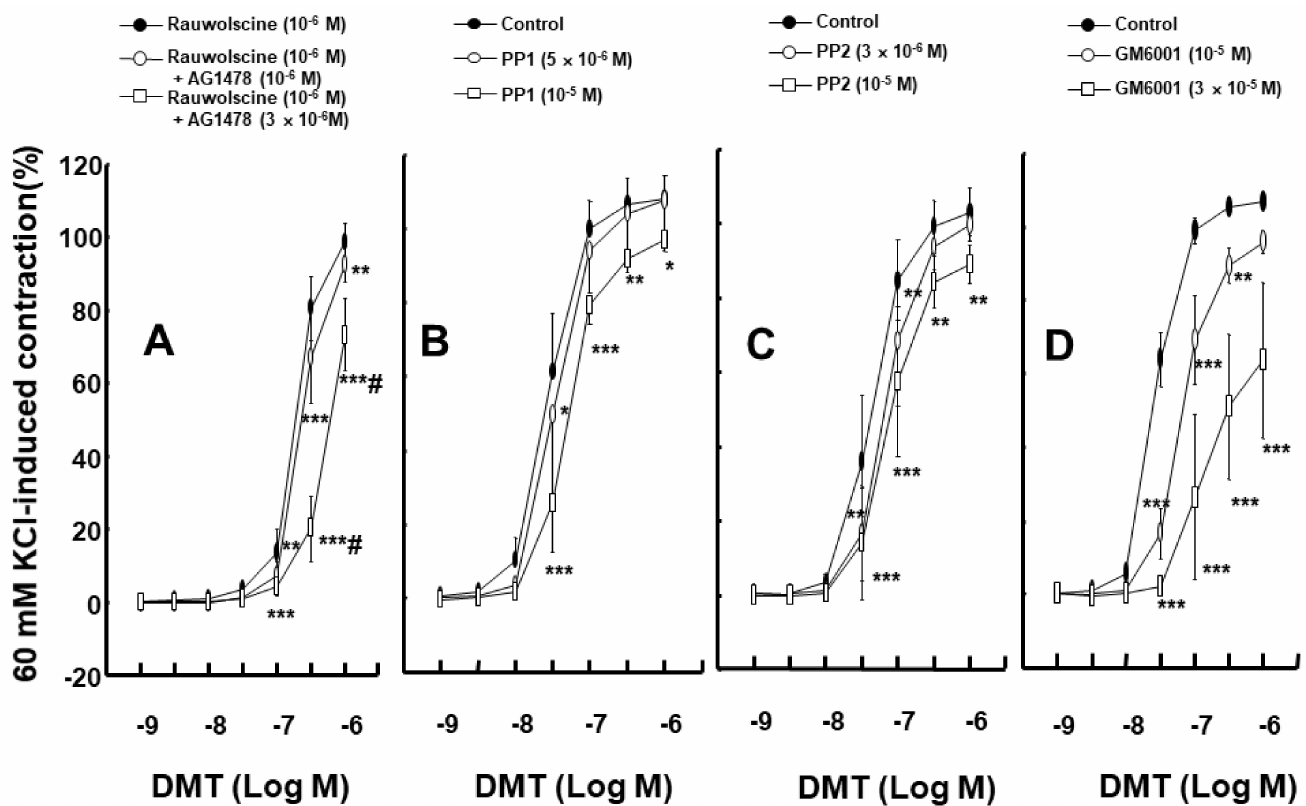
Figure 2. ( A ): Effect of AG1478 (N = 7, 6, and 5 for rauwolscine alone, rauwolscine plus 10 − 6 M AG1478, and rauwolscine plus 3 × 10 − 6 M AG1478, respectively) on dexmedetomidine (DMT)- induced contraction in isolated endothelium-denuded rat aortas pretreated with 10 − 6 M rauwolscine. Data are shown as mean ± SD and are expressed as a percentage of isotonic 60 mM KCl-induced contraction. N indicates the number of rats. ** p < 0.01 and *** p < 0.001 versus rauwolscine alone. # p <0.001 versus 10 − 6 M rauwolscine plus 10 − 6 M AG1478. ( B – D ): Effects of PP1 (( B ) N = 6, 5, and 6 for control, 5 × 10 − 6 , and 10 − 5 M PP1, respectively), PP2 (( C ) N = 6, 5, and 6 for control, 3 × 10 − 6 , and 10 − 5 M PP2, respectively), and GM6001 (( D ) N = 5, 5, and 6 for control, 10 − 5 and 3 × 10 − 5 M GM6001, respectively) on DMT-induced contraction in isolated endothelium-denuded rat aortas. Data are shown as mean ± SD and are expressed as a percentage of isotonic 60 mM KCl-induced contraction. N indicates the number of rats. Control indicates no treatment. * p < 0.05, ** p < 0.01, and *** p < 0.001 versus